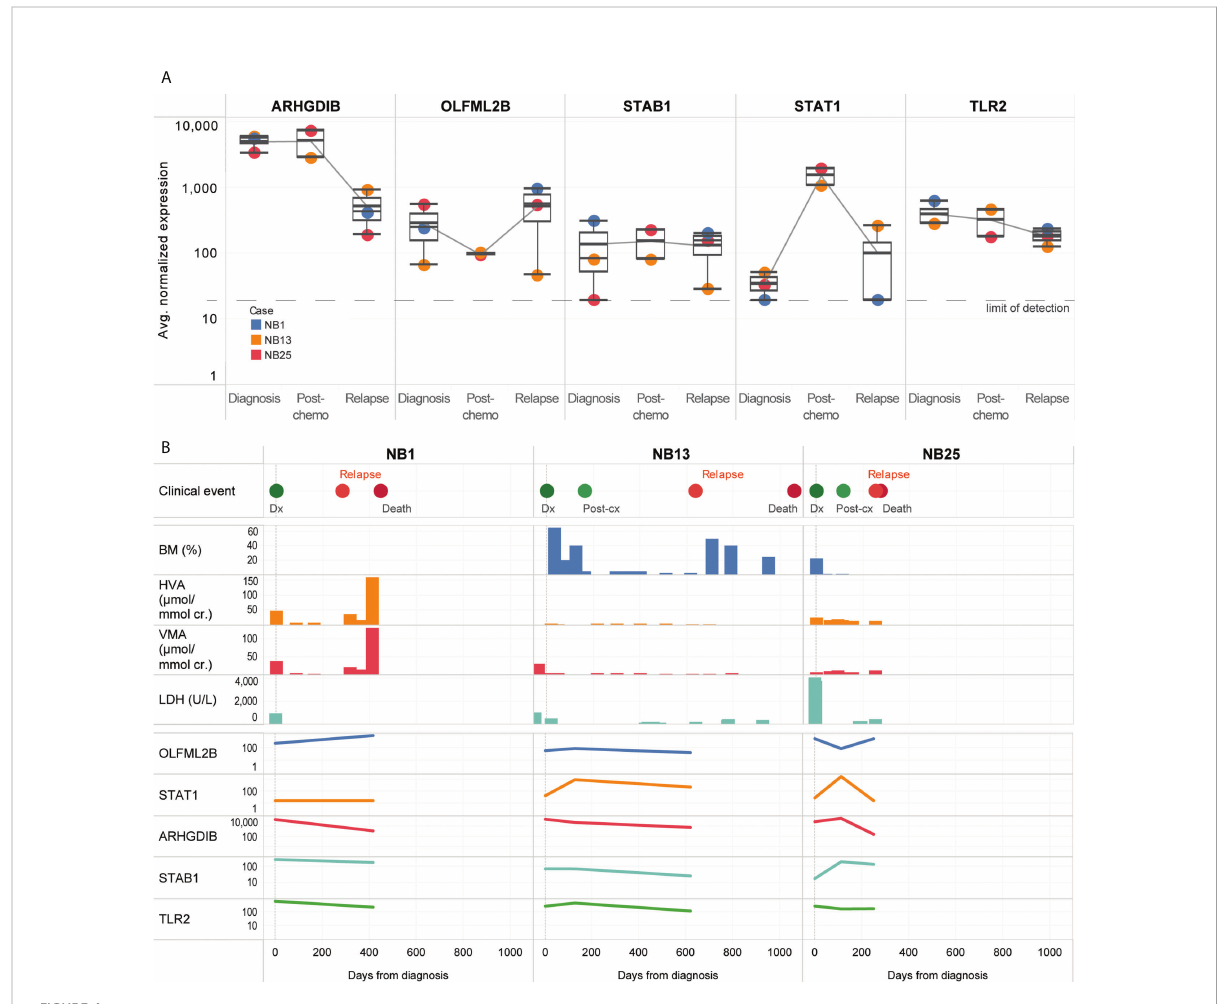
FIGURE 4 CTCs of relapse patients show persistent upregulation of genes related to interleukin and JAK/STAT signaling. (A) Boxplots showing distribution of normalized gene expression of 5 genes which were persistently elevated in 3 patients with disease relapse, at diagnosis, post-chemotherapy and relapse. (B) Graphical time course illustration of disease markers in 3 patients with disease relapse. Top panel: clinical events. Middle panel: serial values of standard clinical markers of disease including percentage of tumor involvement of bone marrow trephines, urinary catecholamines and serum tumor markers (BM: bone marrow, HVA: homovanillic acid, VMA: vanillylmandelic acid, LDH: lactate dehydrogenase). Lower panel: relative expression of 5 genes persistently elevated in CTCs of relapse